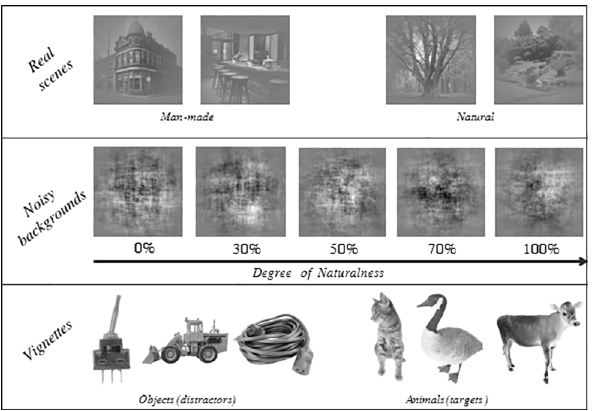
Fig 1. First line: examples of real scenes; second line: examples of noisy backgrounds with an increasing degree of naturalness; third line: examples of vignettes